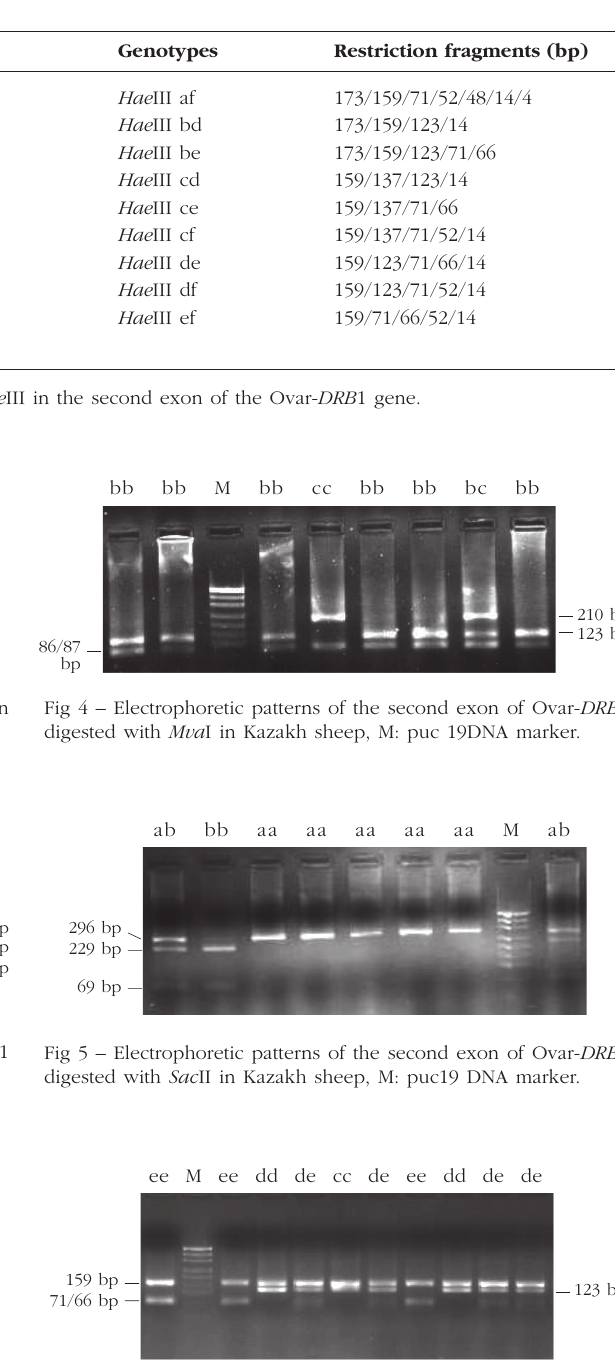
Fig 6 – Electrophoretic patterns of the second exon of Ovar- DRB 1 digested with Hae III in Kazakh sheep, M: puc19